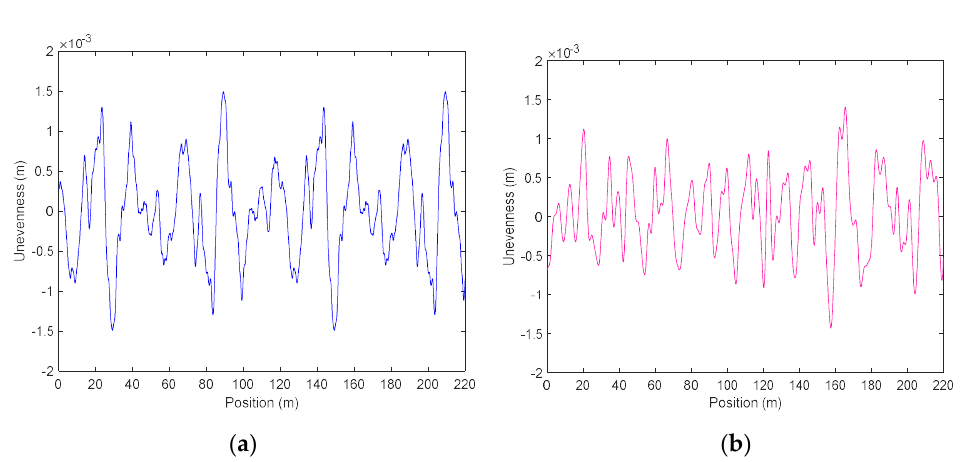
Figure 3. Track irregularity sample: ( a ) vertical and ( b ) lateral direction.